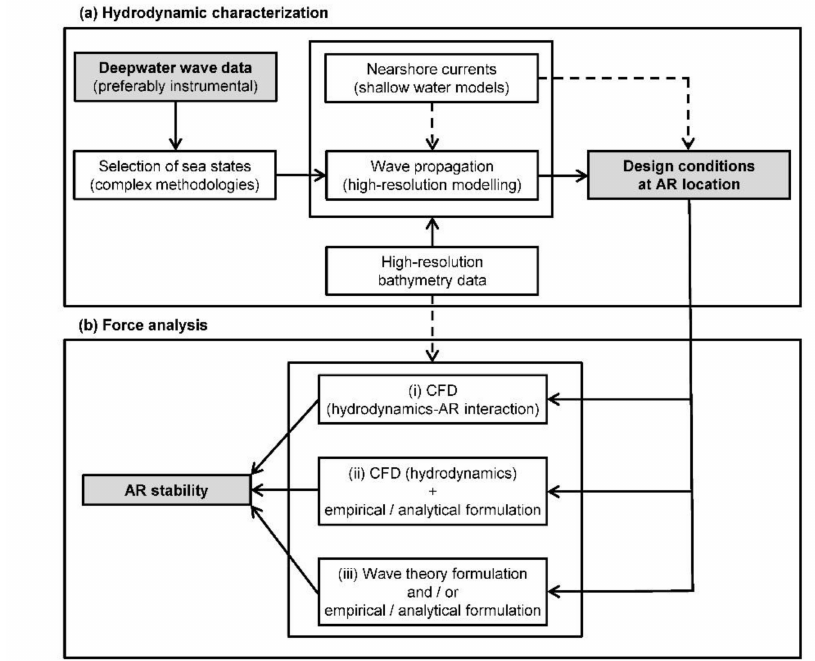
Figure 5. Flowchart of the process to be followed for AR stability analysis, including both hydro- dynamic characterization as well as force analysis. The dashed lines indicate that the flow is only mandatory in the case of the presence of strong